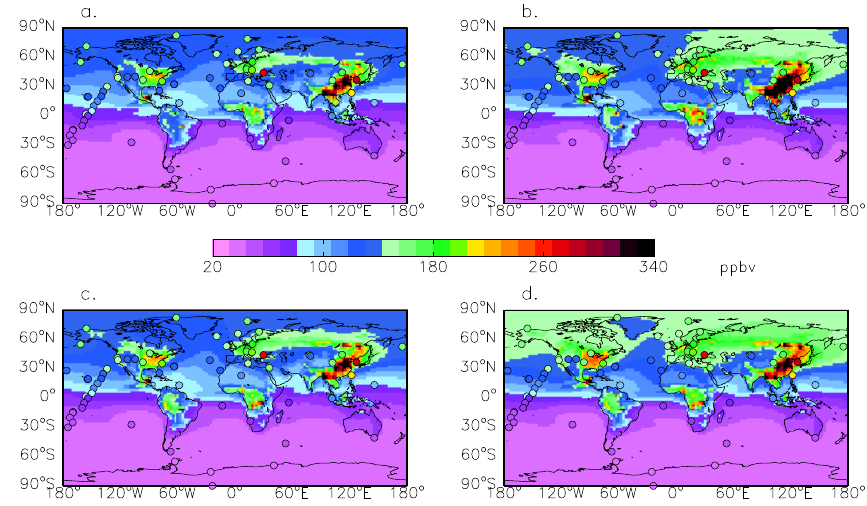
Figure 6. CO for March through May of 1999–2009 from the GMD observations (circles) overplotted on the surface CO from (a) RefGMI, (b) GMI-HiEmis, (c) RefCOonly, and (d) COonlyLowNHOH